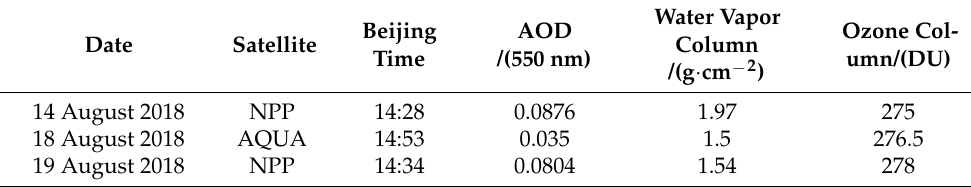
Table 5. Atmospheric parameters of Aqua/MODIS and